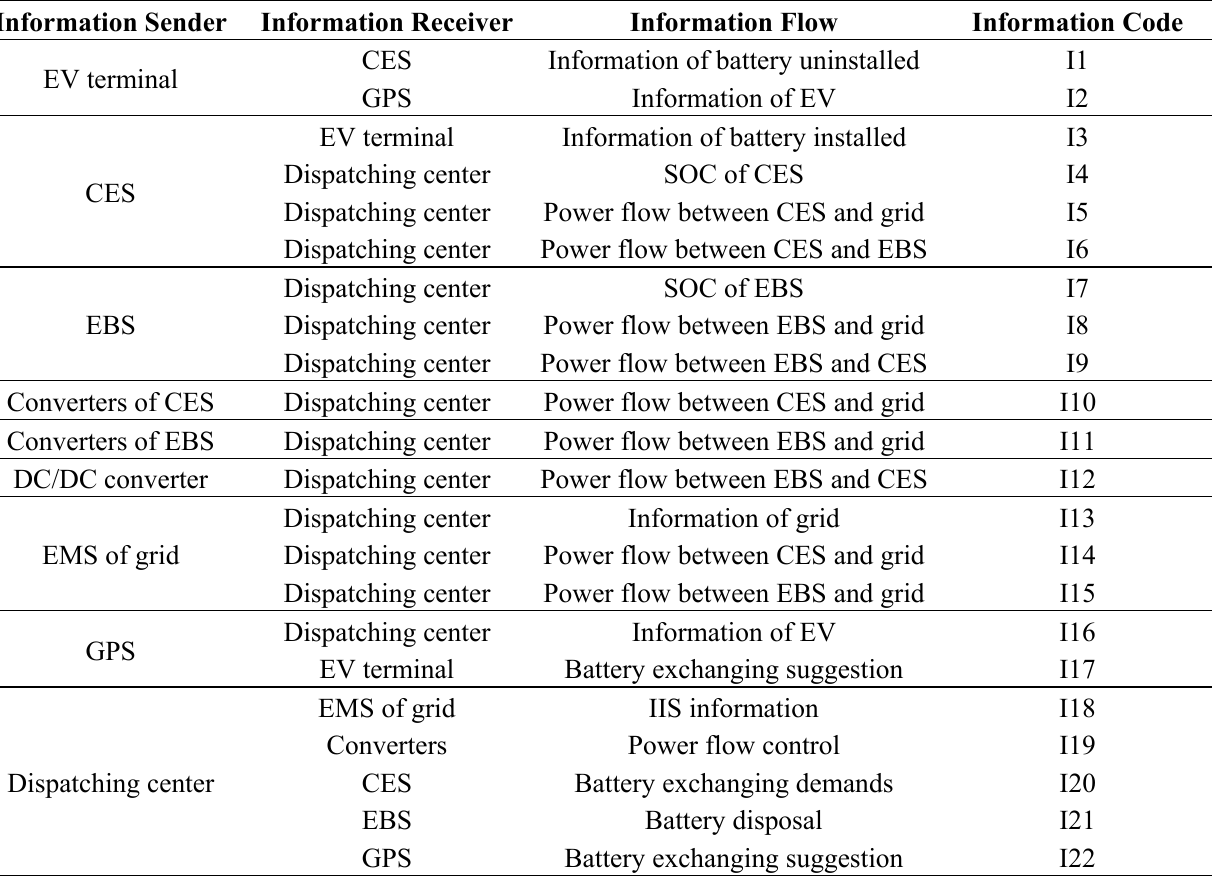
Table 1. Information flow in intelligent integrated station